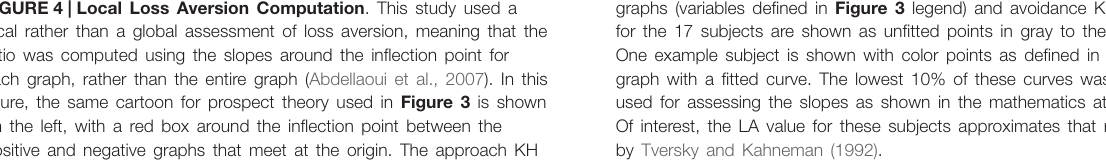
FIGURE 4 | Local Loss Aversion Computation . This study used a local rather than a global assessment of loss aversion, meaning that the ratio was computed using the slopes around the inflection point for each graph, rather than the entire graph (Abdellaoui et al., 2007). In this figure, the same cartoon for prospect theory used in Figure 3 is shown on the left, with a red box around the inflection point between the positive and negative graphs that meet at the origin. The approach KH